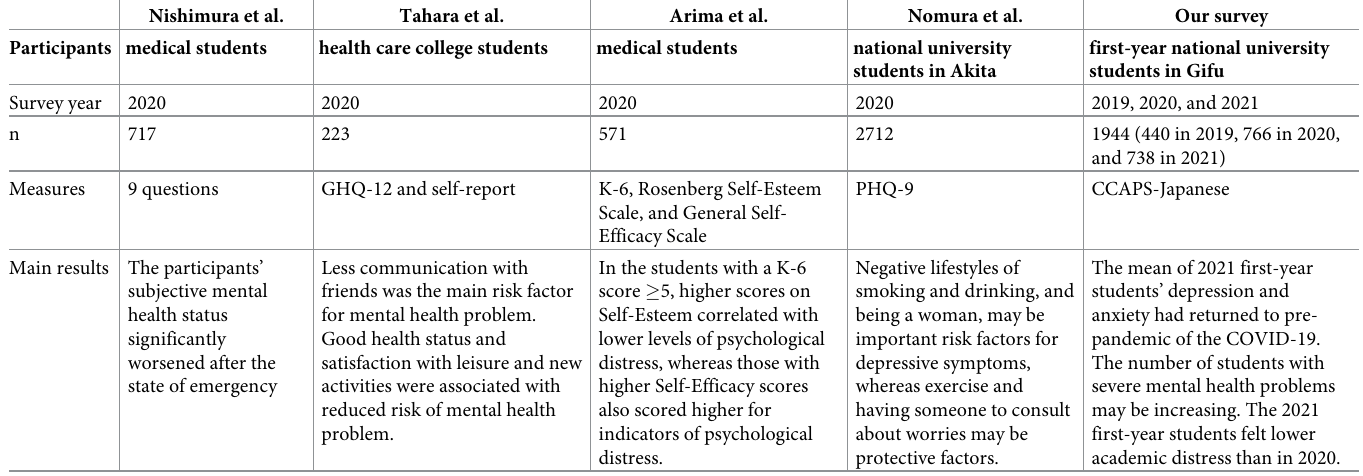
Table 6. Comparison of the